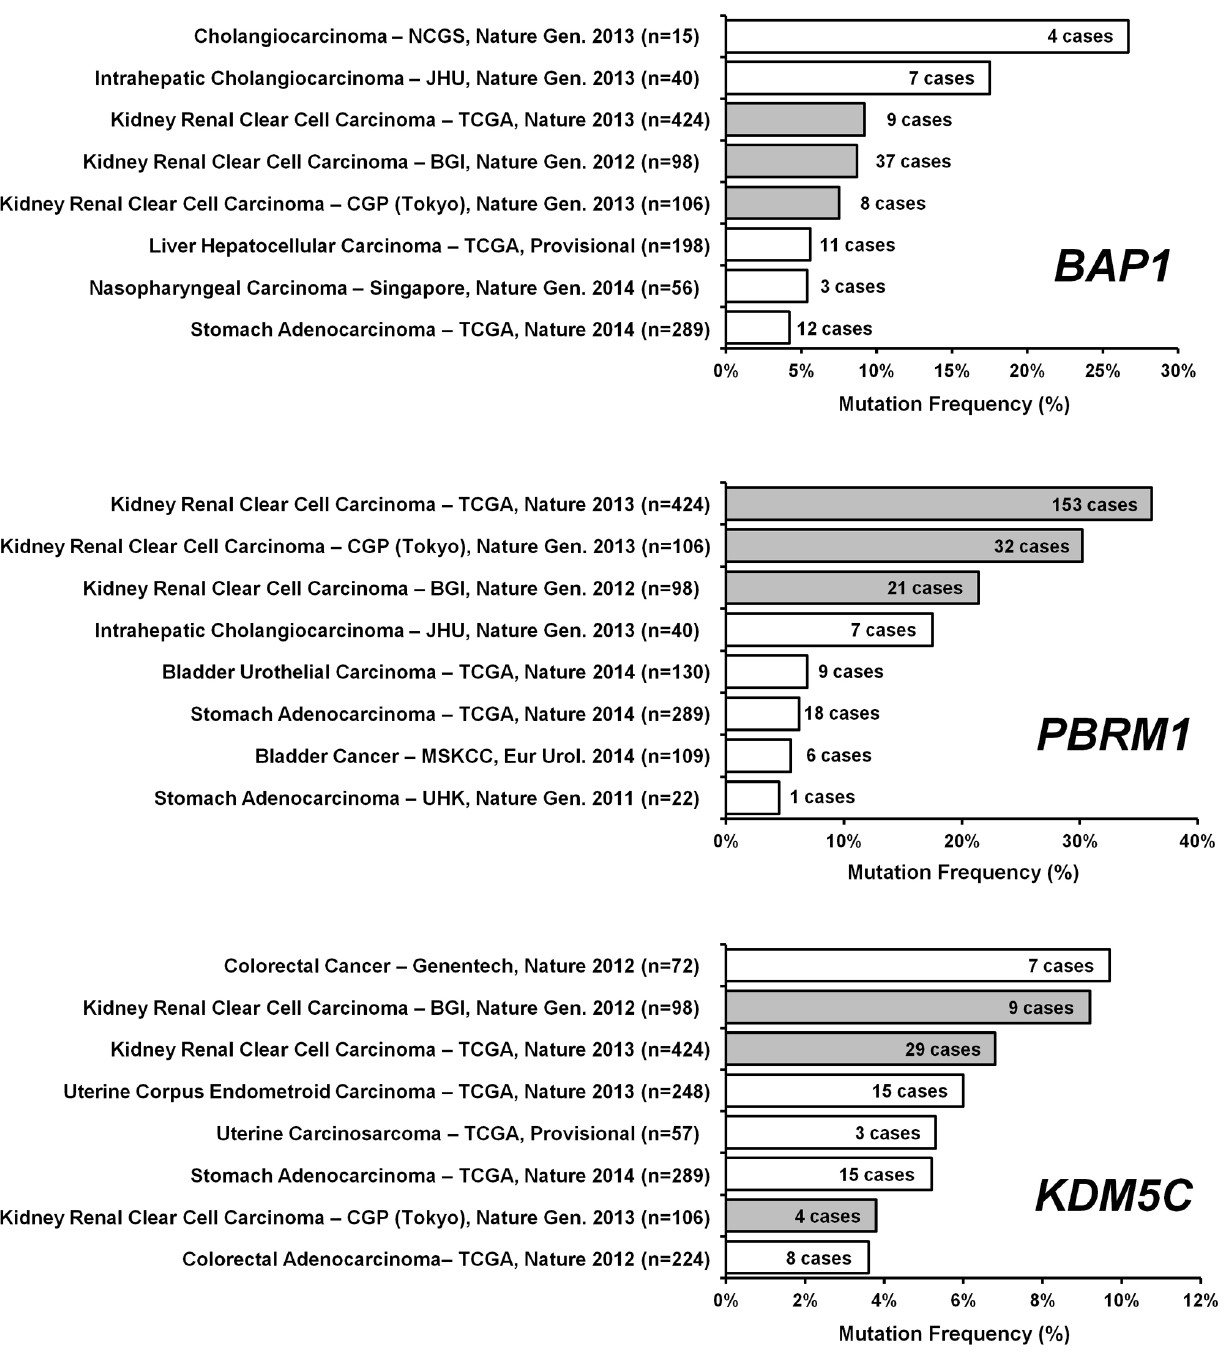
Fig 2. Comparative Mutation Frequencies of CCRCC-Associated Genes in Cancer. The relative mutation frequencies of PBRM1 , BAP1 and KDM5C in the three CCRCC cohorts were compared to the large number of cancer genome studies listed within the cBioPortal software (http://www.cbioportal.org/ index.do) [6,7]. The three CCRCC cohorts were highlighted in grey with the TCGA cohort referred to as TCGA, Nature 2013, the Sato et al cohort referred to as CGP (Tokyo), Nature Gen. 2013 and the Guo et al cohort referred to as BGI, Nature Gen. 2013.